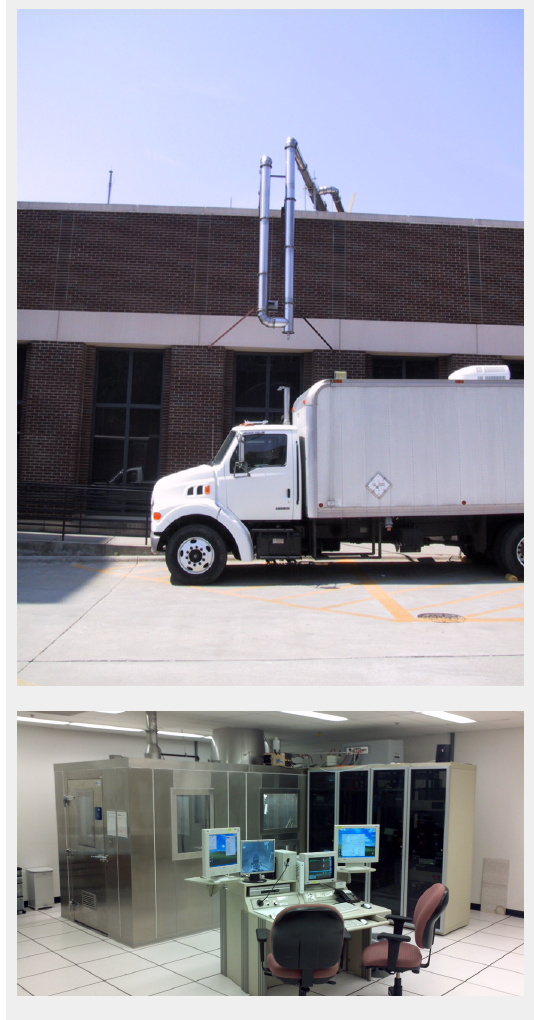
Diesel exhaust is collected from an idling truck parked outside the building (A). This is diluted with filtered air and introduced through piping into an exposure chamber